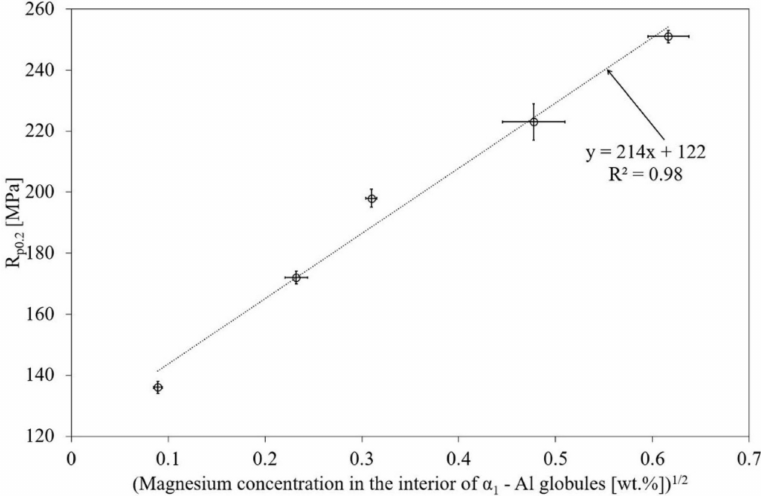
Figure 12. R p0.2 as a function of the square root of the magnesium concentration in the interior of α 1 -Al globules of SSM castings in the T5 and T6 conditions. The dashed line shows the best fit for the presented data. Error bars show the standard deviation of the